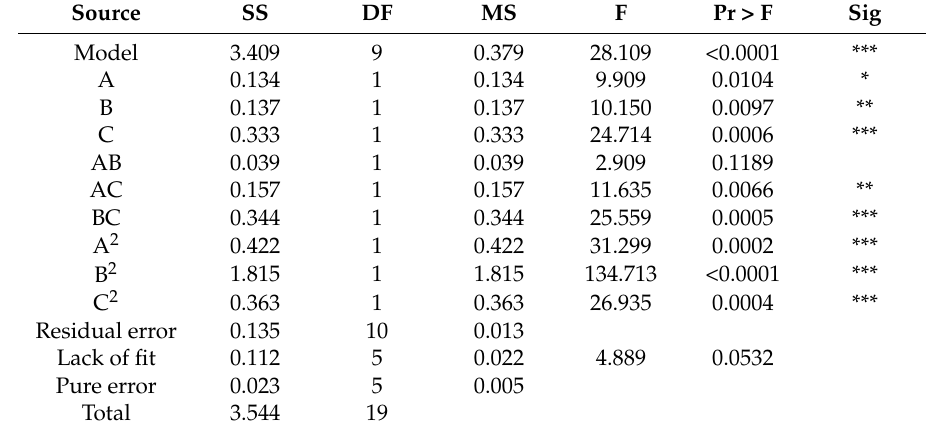
Table 2. The ANOVA of the